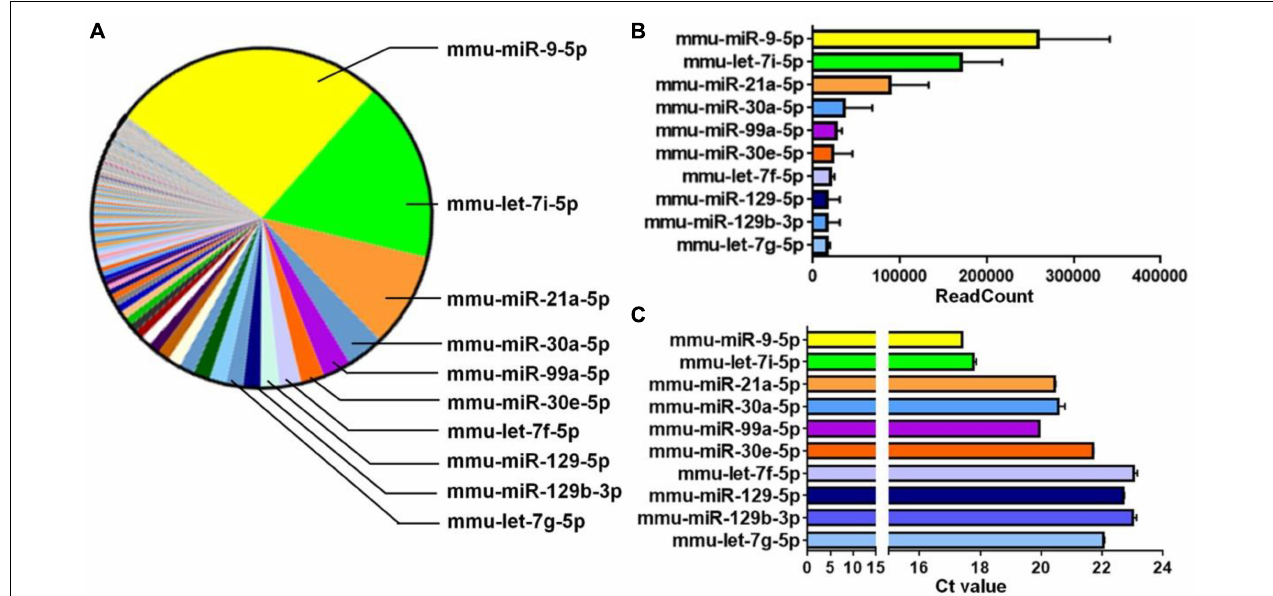
FIGURE 3 | miR-9 is predominantly expressed in EXOs. (A) The microRNAs (miRNAs) profiles of NSC-derived exosomes were determined by miRNA microarray and a parts of whole table for the readcounts of all detected miRNAs was generated. The 10 miRNAs with the most readcounts were marked on the right. (B) The readcounts of the top 10 most abundantly expressed miRNAs. Data were represented as mean ± SD from three independent biological samples. (C) The Ct value of RT-qPCR analysis for the top 10 most abundantly expressed miRNAs, identified by miRNA microarray, in NSC-derived exosomes. Data were represented as mean ± SE from three independent